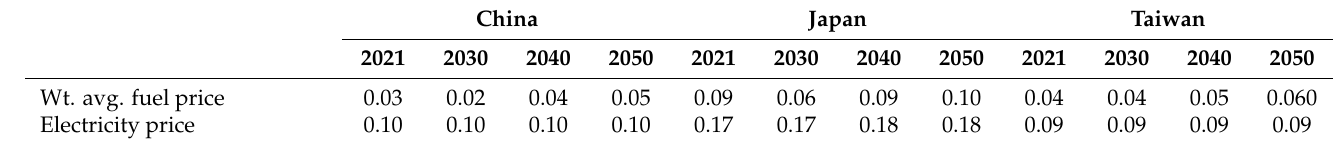
Table 5. Energy prices for industry (2021 US dollars per kilowatt hours—USD/kWh).